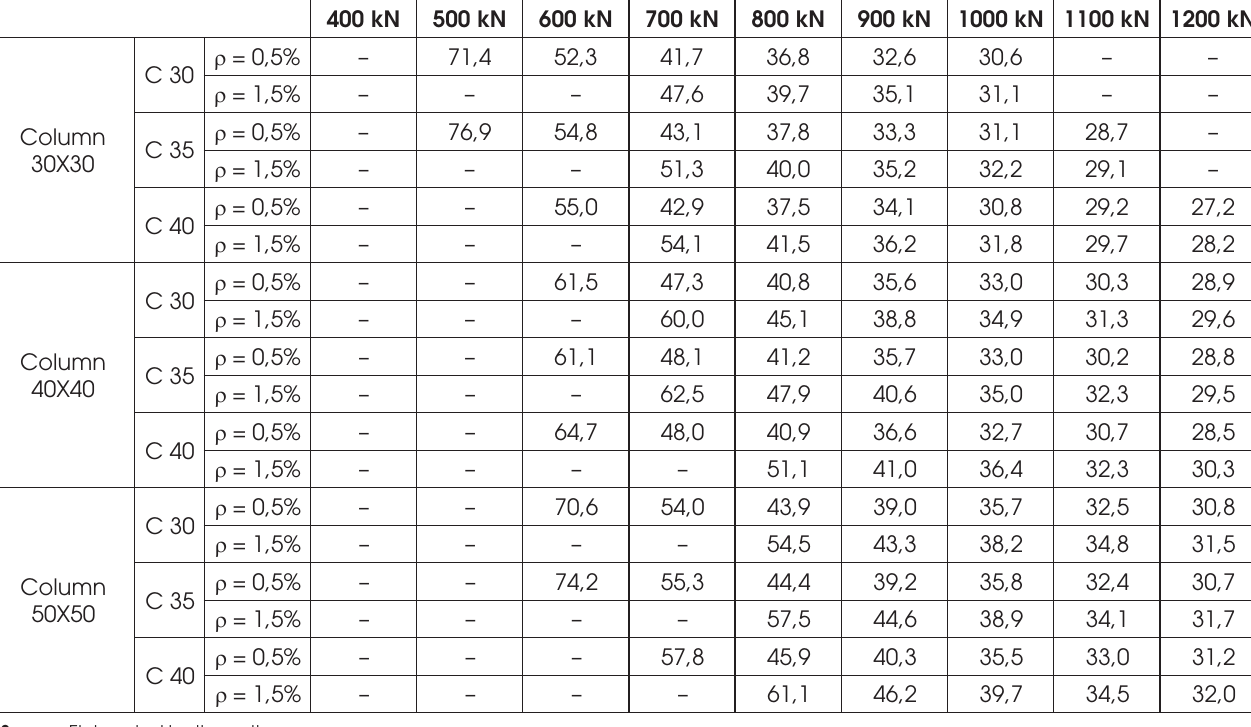
Percentual reduction by Comparison 2, considering s